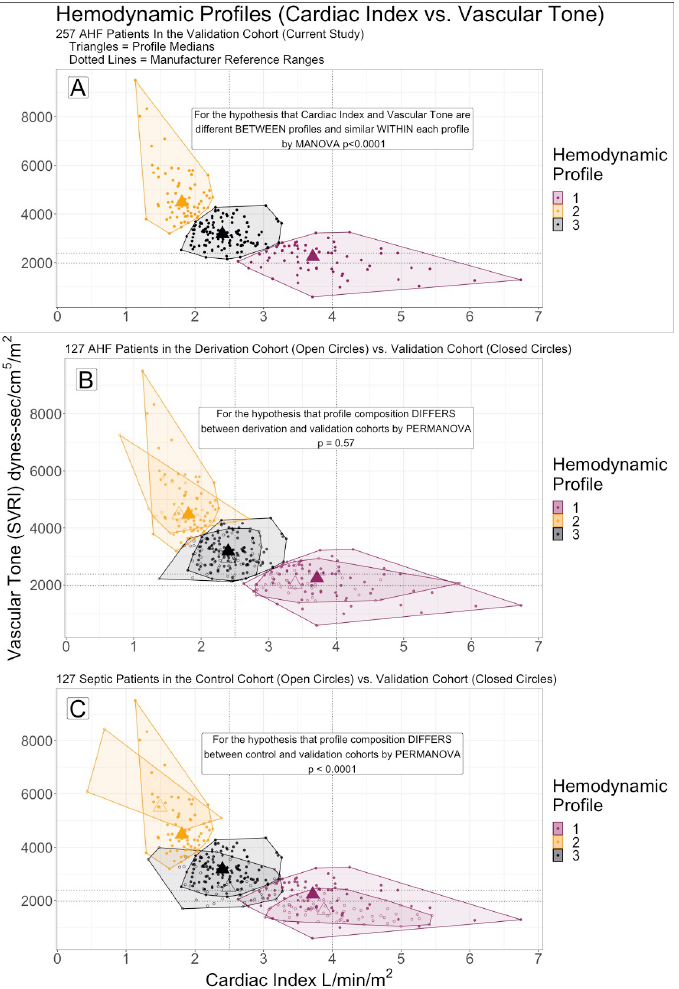
Fig 2. Hemodynamic profiles by cardiac index vs. vascular tone (systemic vascular resistance index, SVRI). Profiles were numbered similarly to facilitate between cohort comparisons: 1 (purple)—lowest SVRI and highest cardiac index, 2 (gold)—highest SVRI and lowest cardiac index, 3 (black) cardiac index and SVRI between profiles 1 and 2. (A) Profiling in the validation cohort (VC) alone. (B) The VC patients and their profiles are overlayed with the derivation cohort (DC). Patients in the DC had acute heart failure and were monitored in the emergency department like the VC, but were enrolled in a prior study (external cohort). Few patients classified in a particular profile in the VC would have been classified differently in the DC. (C) The VC overlayed with the control cohort (CC). The CC included patients enrolled in the same study as the DC, but who had sepsis rather than AHF. Profiling in the CC differed from VC, with several VC patients who would have been classified in a different profile by profiling of the CC (and visa